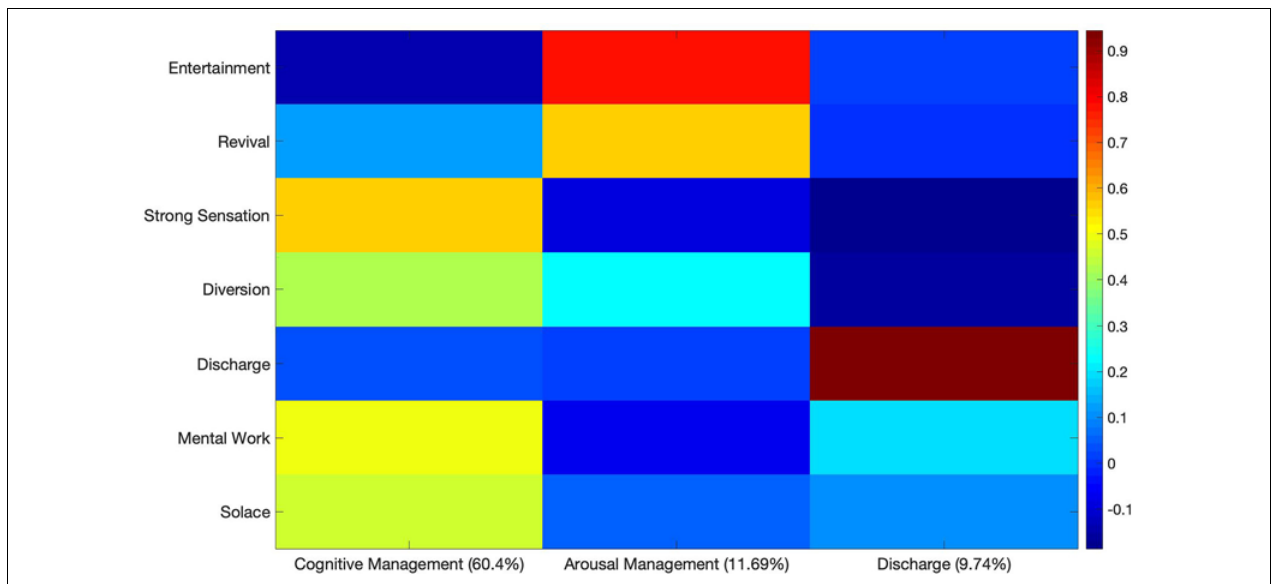
FIGURE 6 | Varimax-rotated PCA solution for participants musical-engagement. Four components account for a collective 61.94% of the variance.